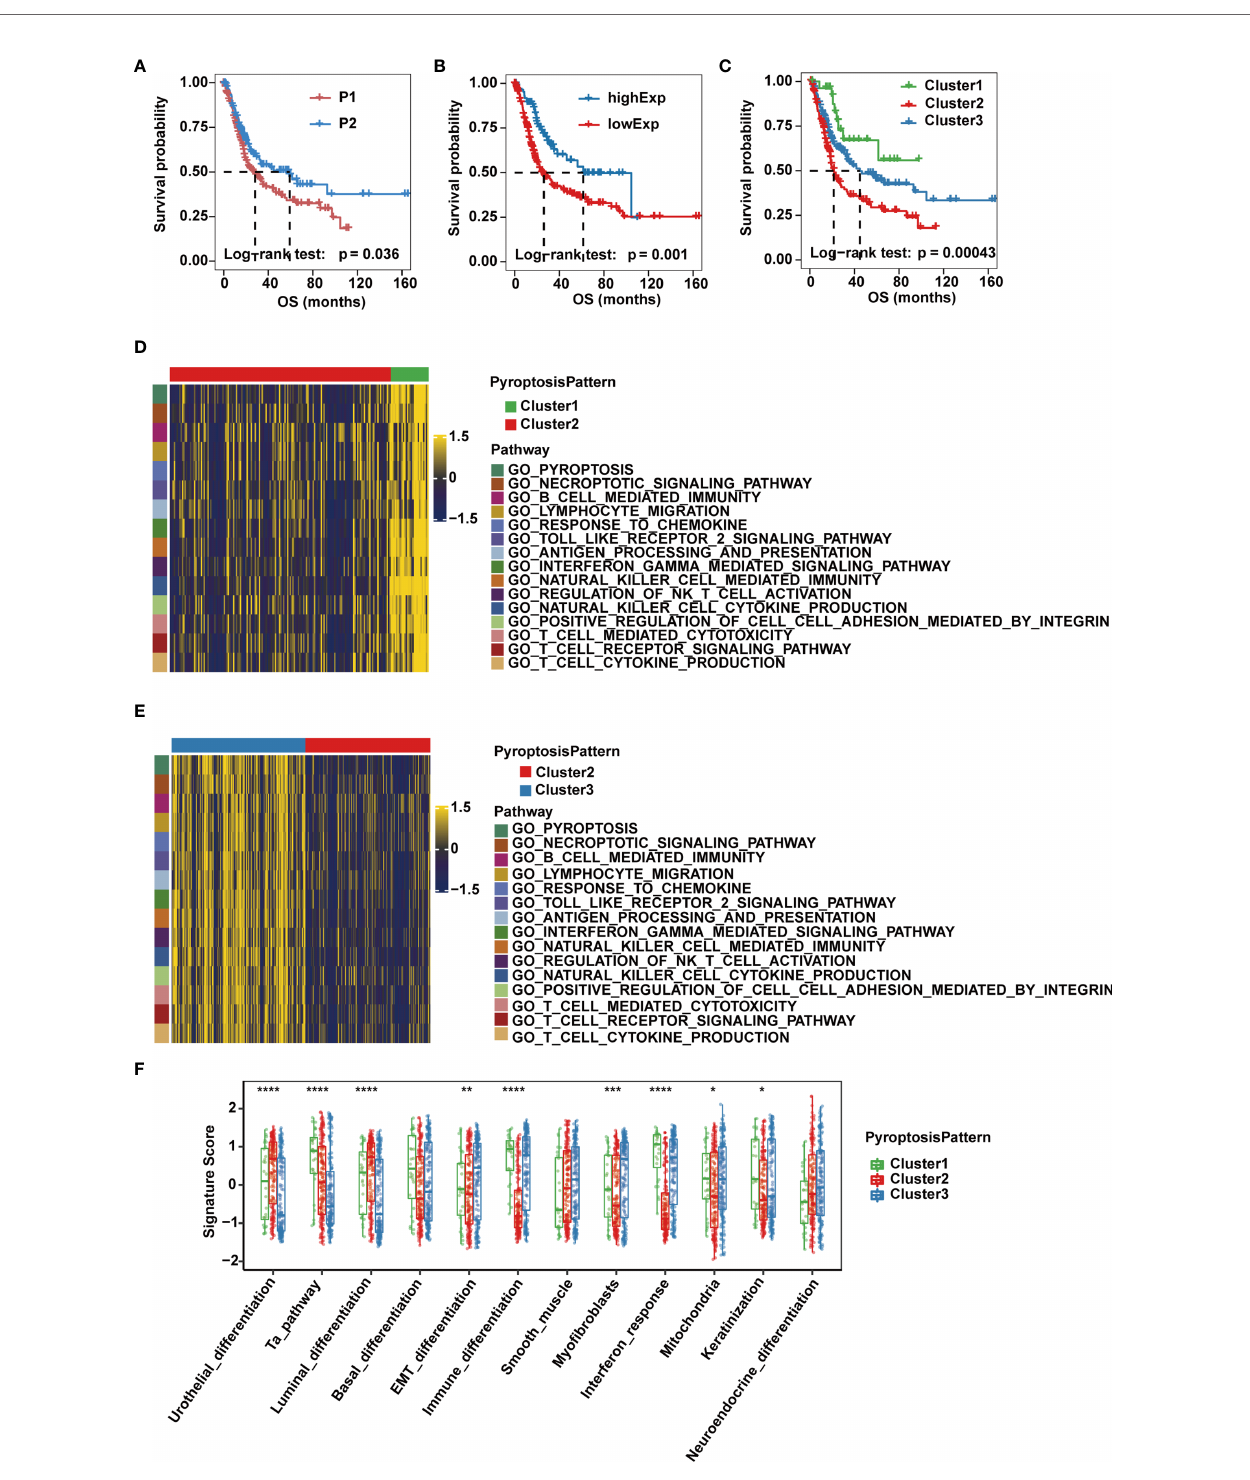
FIGURE 2 | Pyroptosis patterns and biological characteristics of each pattern in the TCGA-MIBC cohort. (A) Kaplan-Meier curve for the two cleavage enzyme regulation patterns. (B) Survival analysis for patients with high or low GSDMB expression using Kaplan-Meier curves. (C) Survival analysis of the three pyroptosis patterns based on two cleavage enzyme regulation patterns and GSDMB expression. (D, E) Heatmaps showing differentially enriched biological pathways in the three pyroptosis patterns by GSVA. (F) GSVA enrichment analysis representing the signi fi cance of differential expression of speci fi c bladder cancer-related signatures among the three pyroptosis patterns. The asterisks represent the statistical P value (*p < 0.05; **p < 0.01; ***p < 0.001; ****p <